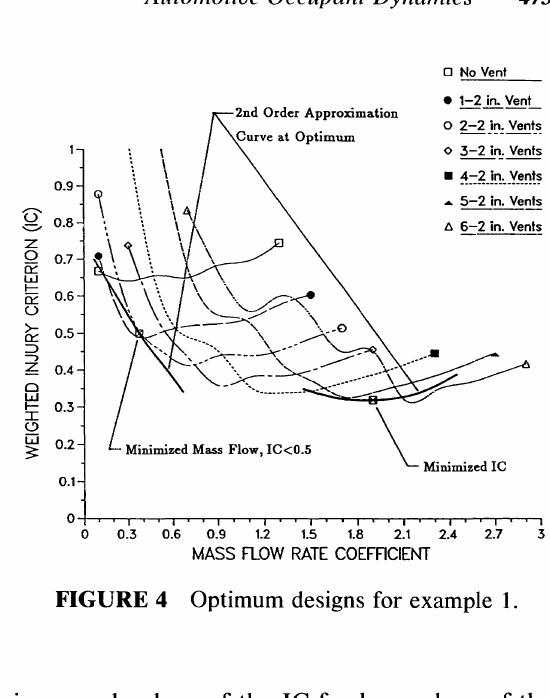
FIGURE 4 Optimum designs for example